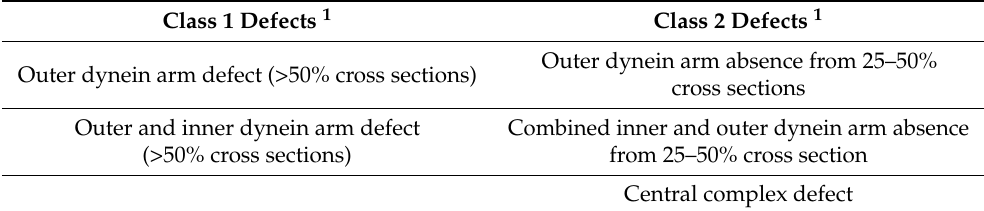
Table 1. Summary of Class 1 and Class 2 defects for the ultrastructural diagnosis of PCD (Modified BEAT PCD Criteria).